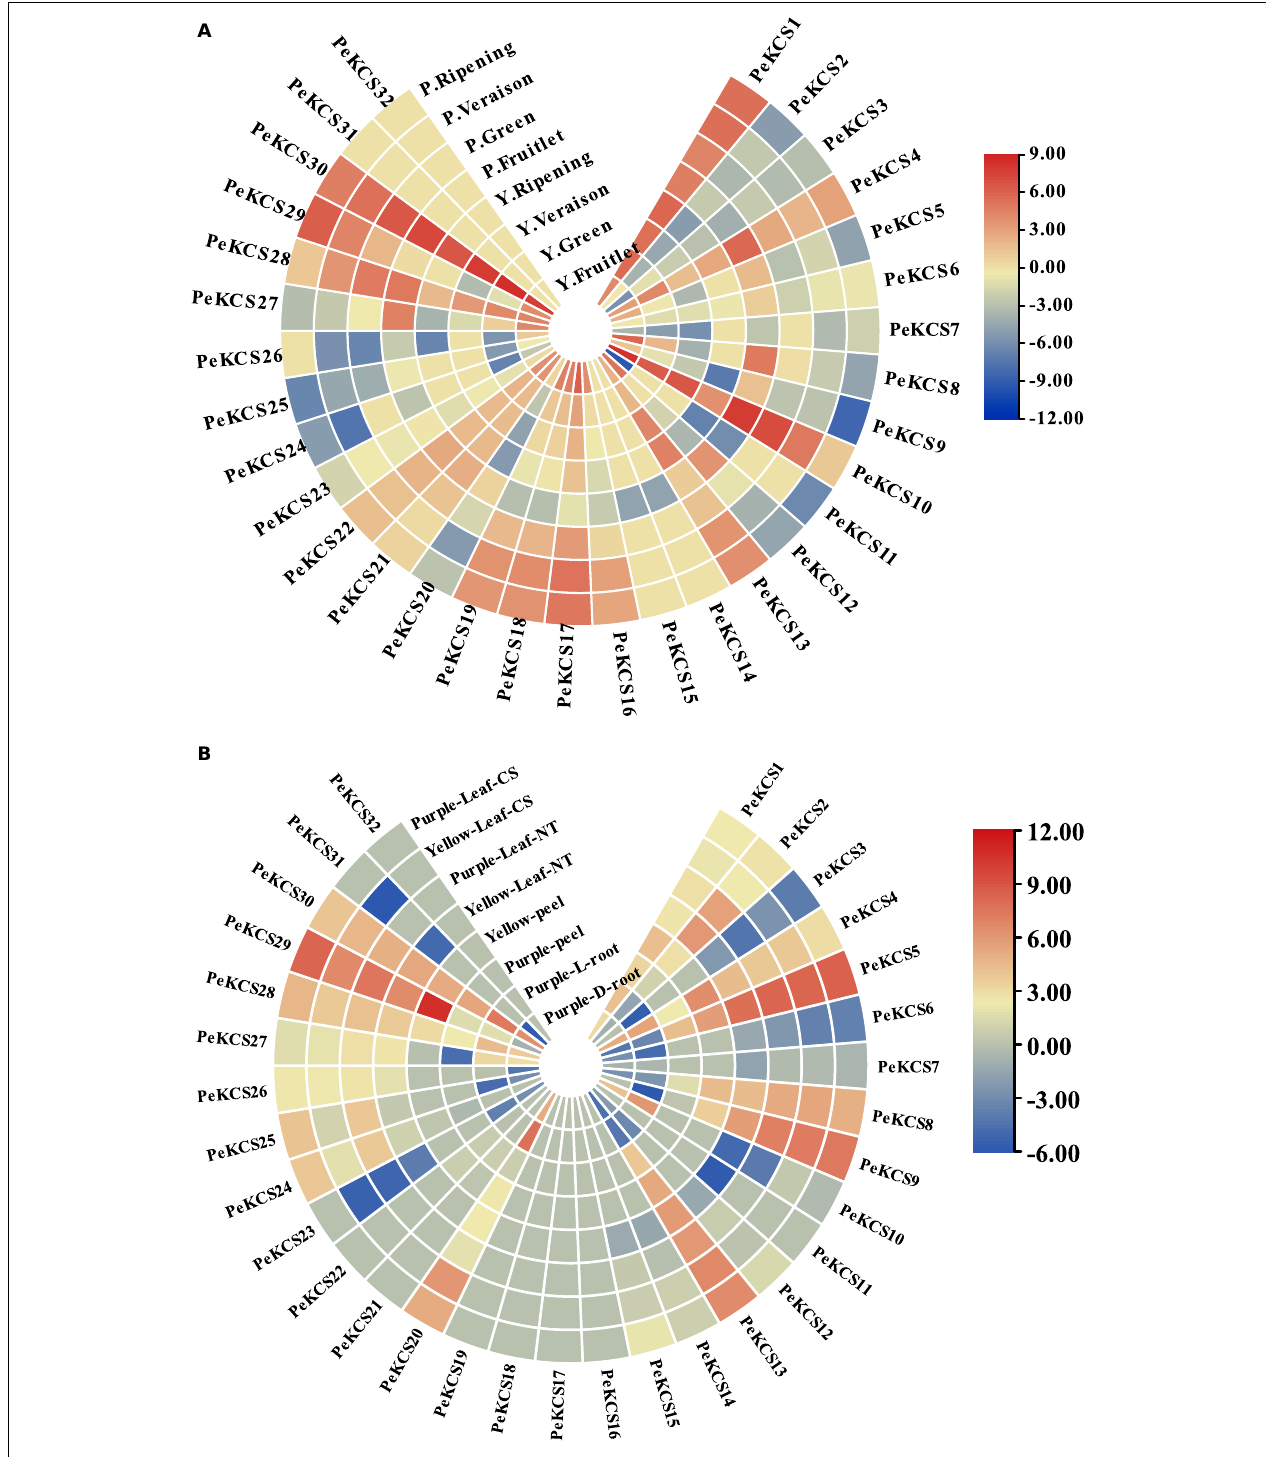
FIGURE 11 | Circular heatmap showing the expression profiles of PeKCS genes in pulp, root, peel, and leave tissues of yellow and purple cultivar under different conditions. (A) PeKCS expressions in pulp of yellow and purple passion fruit cultivars at different developmental stages. (B) PeKCS genes expressions in root, peel, and leaves of yellow and purple passion fruit cultivars under different conditions. Y and L represents the yellow (Y) and purple (P) passion fruit cultivars. L and D represents the samples from limestone (L) and sandy dolomite (D) rocky desertification areas. The NT and CS indicate the normal temperature (NT) and chilling stress (CS) conditions. Fragments per kilobase per million (FPKM) values of PeKCS genes all tissues were transformed by log2 and heatmap was constructed by TBTools software (the red color shows the highest and the blue color shows lowest expression levels in expression bar).